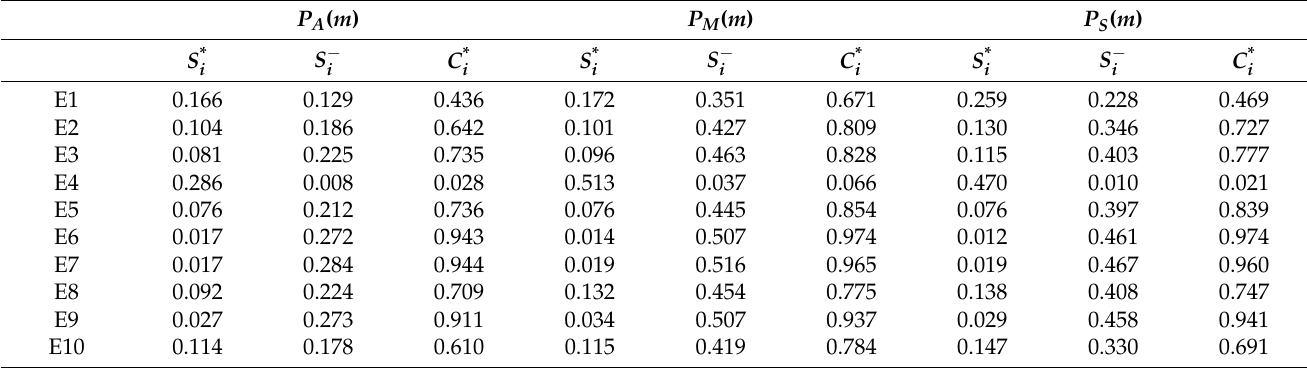
Table 7. Distances from ideal and negative-ideal solutions and relative closeness to ideal